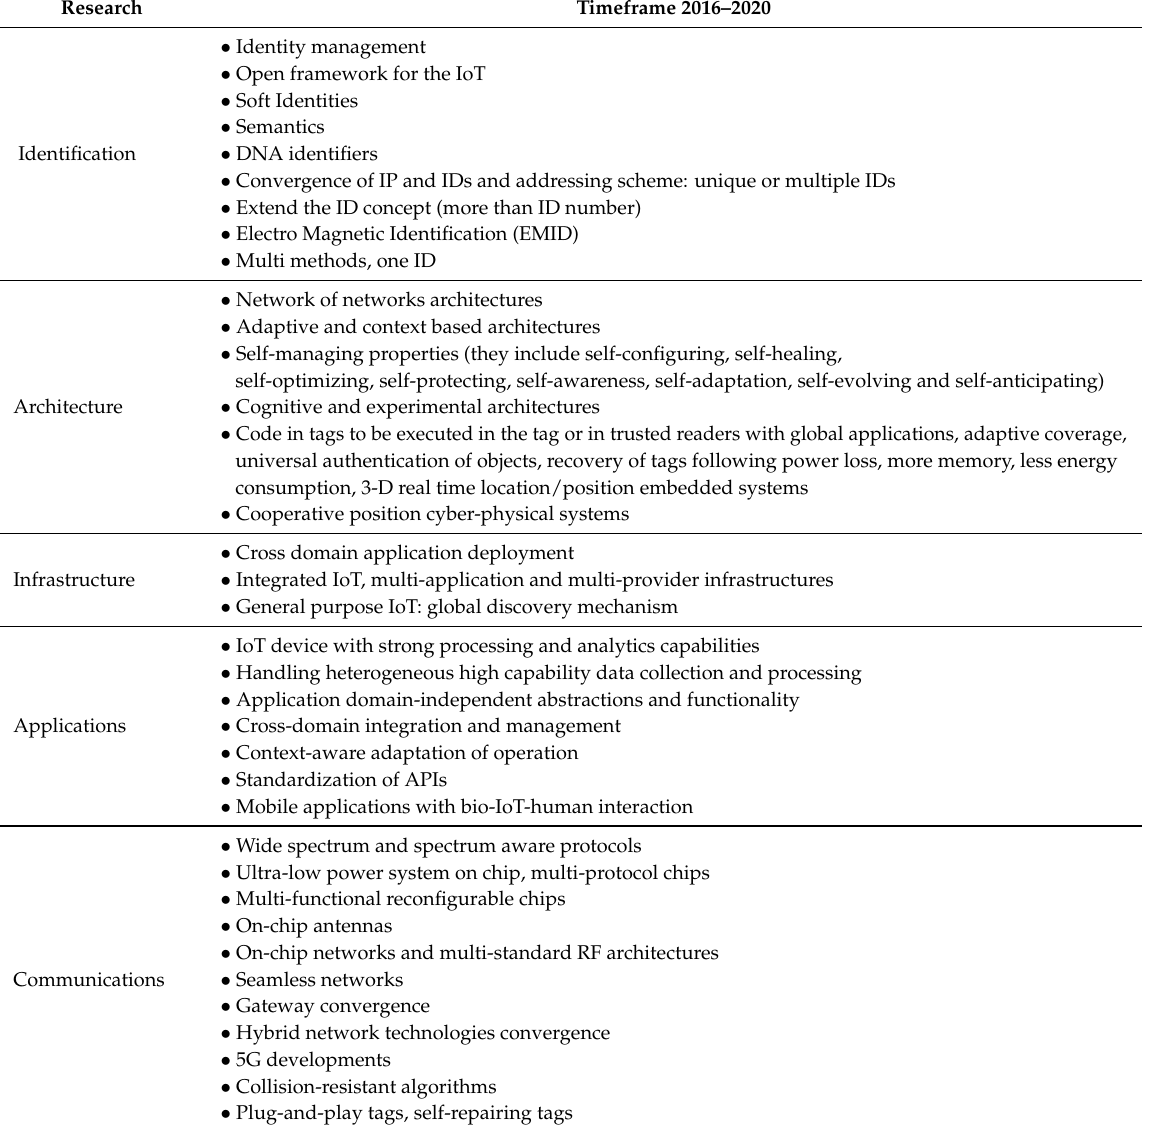
Table 2. Roadmap for technologies and ongoing